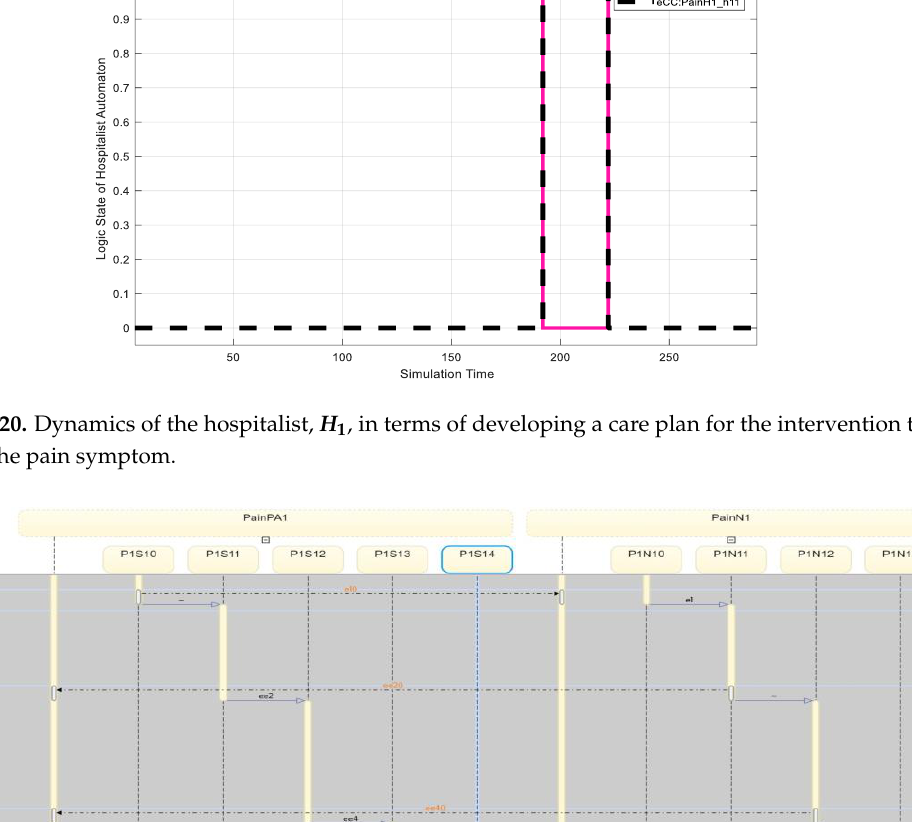
Figure 21. The 𝑷𝑨 𝟏𝒐 automaton interacts with the nursing station (𝑵 𝟏 ) regarding the pain symptom via time-stamped coupling events.